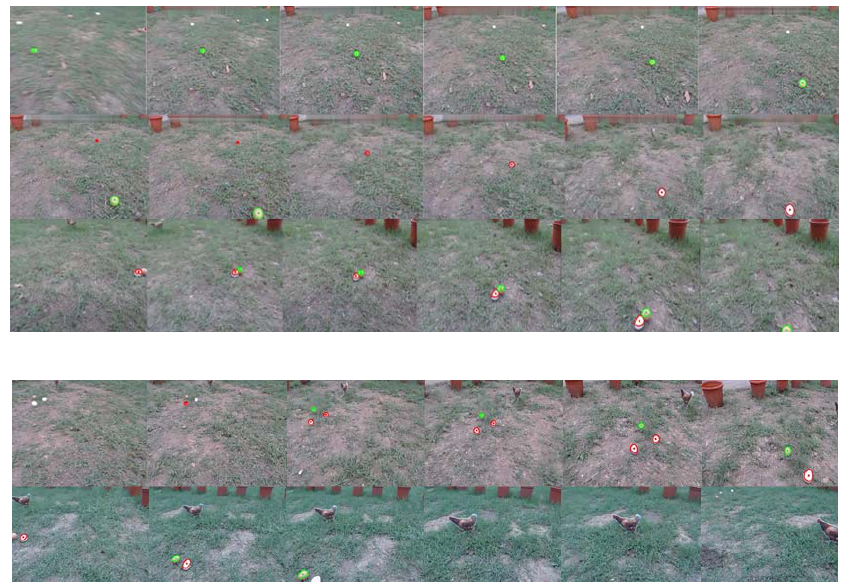
Figure 14. Navigation trajectory for the robot using the GNSS ‐ RTK positioning method.